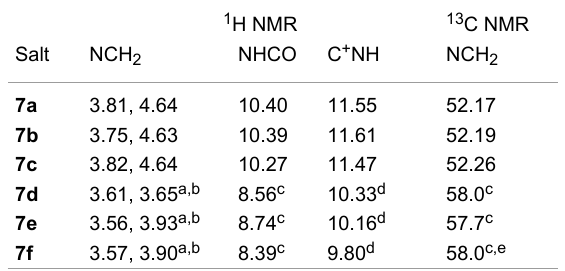
Table 2: Selected 1 H and 13 C NMR data of salts 7 (in DMSO- d 6 , 295–300 K, δ [ppm] vs